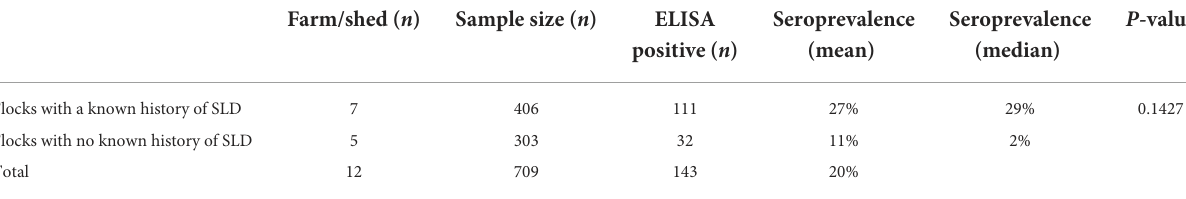
TABLE 2 Seroprevalence of Campylobacter hepaticus in flocks with/without a known history of